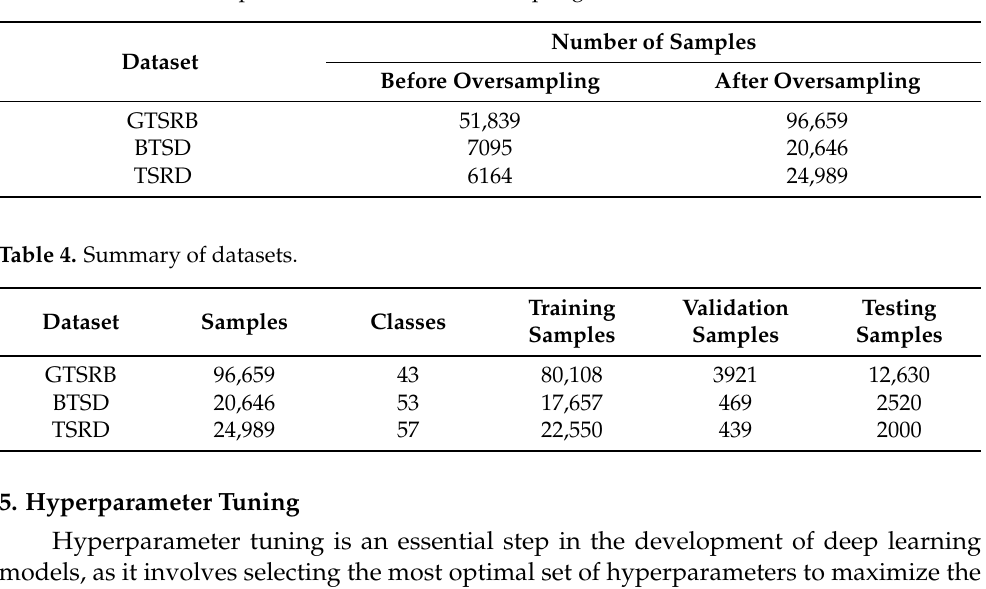
Table 3. Number of samples before and after oversampling.